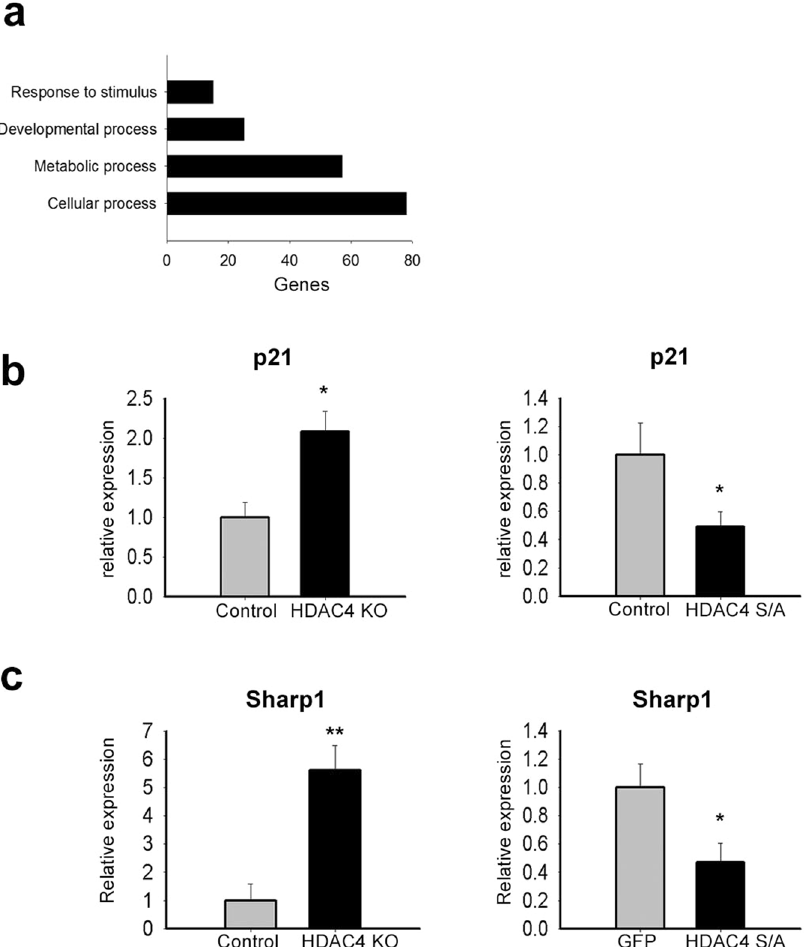
Figure 5. Identification of HDAC4 target genes. ( a ) Gene ontology analyses on 1231 genes differentially modulated by HDAC4 in satellite cell proliferation. ( b ) Expression of P21 in HDAC4 KO and control satellite cells (n = 4 each sample) or in primary myotubes overexpressing the nuclear form of HDAC4 (HDAC4 S/A), compared to GFP-expressing myotubes (n = 5 each sample). Data are presented as mean ± SEM. * p < 0.05 (Student’s t-test). ( c ) Expression of Sharp1 in HDAC4 KO and control satellite cells (n = 4 each sample) or in primary myotubes overexpressing the nuclear form of HDAC4 (HDAC4 S/A), compared to GFP-expressing myotubes (n = 5 each sample). Data are presented as mean ± SEM. * p < 0.05; ** p < 0.005 (Student’s